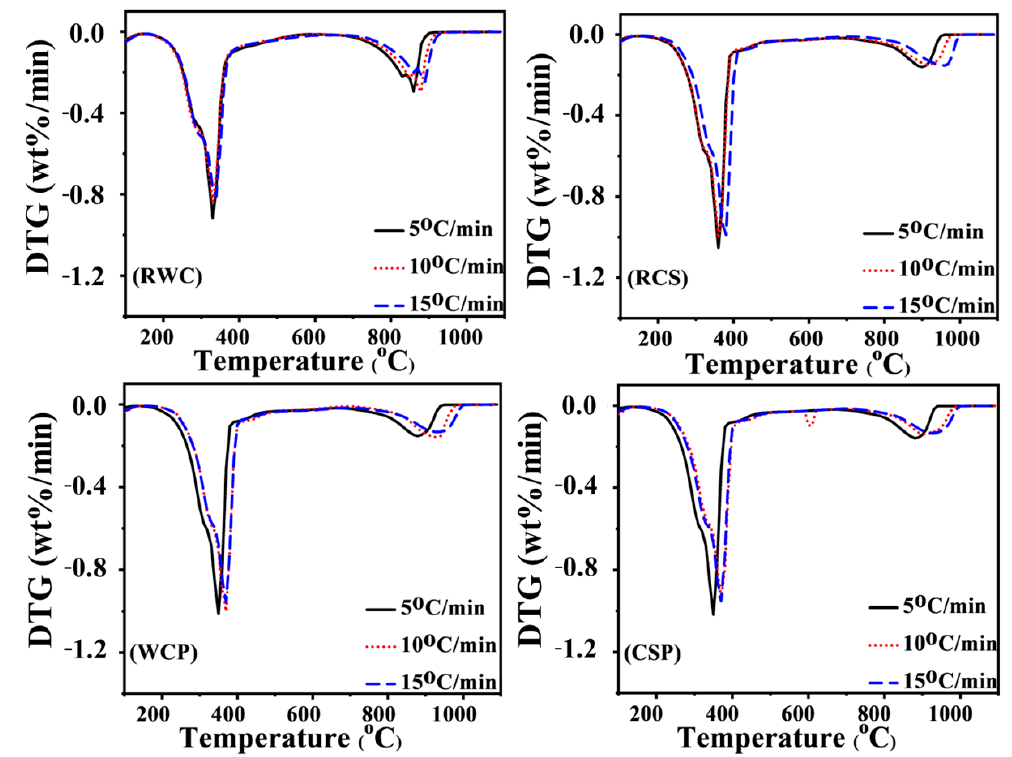
Figure 2. DTG curves of RWC, WCP, RCS, and CSP at heating rates of 5, 10, and 15 °C/min. Table 3. Characteristics parameters of RWC, WCP, RCS, and CSP.